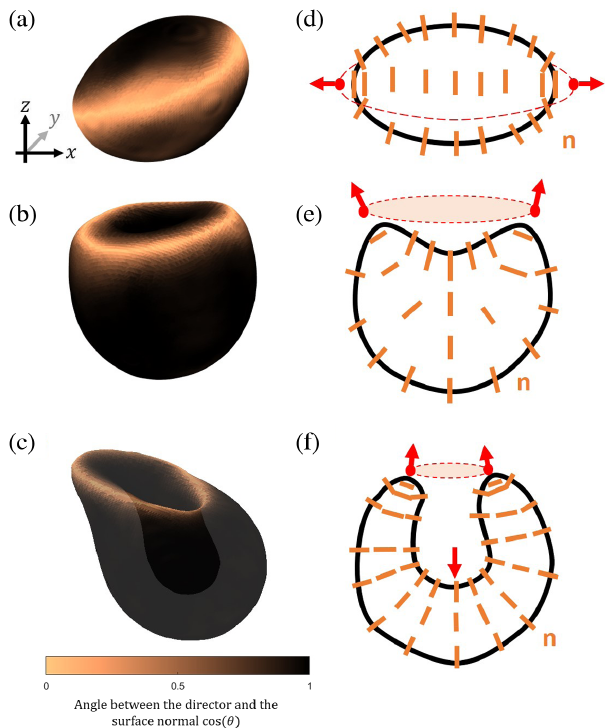
FIG. 12. Initiation of droplet invagination by contractile activity shown by three snapshots at times t 1 < t 2 < t 3 . (a) – (c) show the three-dimensional droplet shape with color coding indicating the local surface alignment of the director field. (d) – (f) are schematic diagrams of the director field n , showing the active forces (red arrows) and the position of the bend ring (red, dotted circle). (d) The ring of in-plane alignment at the equator causes nematic bend deformations in the bulk. Contractile activity causes these bend deformations to push outward (red arrows), thus deforming the droplet to an oblate shape. (e) While the ring of in-plane alignment moves toward one of the poles, the bend deformations in the bulk point perpendicular to the surface, which causes the active forces to develop a component pointing toward the pole. This process creates a dent in the center of the ring. (f) Because of the perpendicular surface alignment caused by active anchoring, the dent in the center of the ring leads to a director splay deformation in the bulk. Contractile activity causes this splay deformation to push inward, thus increasing the depth of the dent. Snapshots created from simulation with elastic constant K